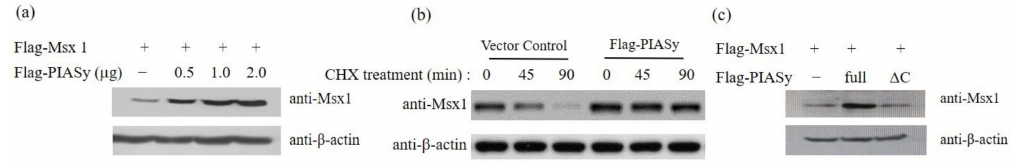
Figure 4. Homeoprotein Msx1-PIASy interaction is critical for suppression of angiogenesis in vitro. ( a ) PIASy-Msx1 interaction is crucial for angiogenesis in vitro. Adenovirus-infected HUVECs were plated on growth factor-reduced Matrigel and then transfected with the indicated PIASy construct expressing full-length (PIASy) or C-terminal-deleted PIASy (PIASy ∆ C) that did not contain the Msx1-interacting domain in the presence of VEGF (10 ng / mL) for 48 h, and tube formation was assessed. The formation of tubular structures was detected by an inverted microscope. Tube length was quantified by measuring the length of tubular structures. The results are expressed as the mean value ± standard deviation (SD). The scale bar represents 100 µ m. ( b ) Quantification of the tube length. Tube lengths were quantified, and error bars correspond to 95% confidence intervals. ** p < 0.01, *** p < 0.001 indicates a significant di ff erence. ( c ) Msx1-PIASy interaction is critical for transcriptional repression of the VEGF promoter in HUVECs. HUVECs were co-transfected with the indicated PIASy construct and the luciferase reporter construct containing the human VEGF promoter sequence. After 18 h, co-transfected HUVECs were further infected with Ad-mock or Ad-Msx1 for an additional 24 h. Total cell lysates were prepared and subjected to a dual luciferase assay to determine VEGF promoter activity, and relative luciferase activity was plotted. * p < 0.05 indicates a significant di ff erence.